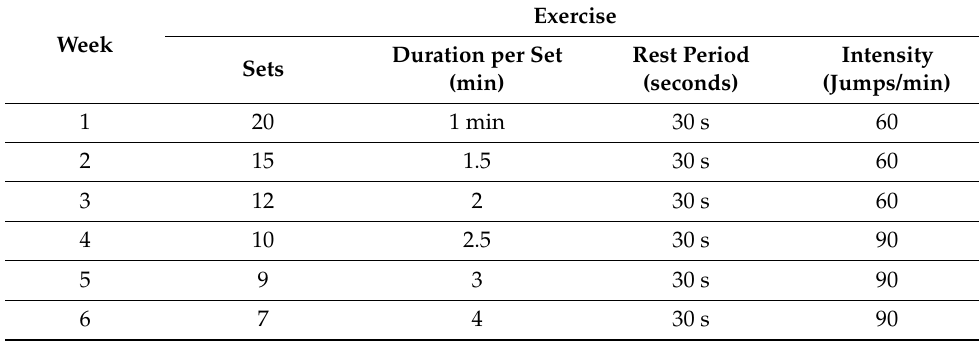
Table 1. Jump rope exercise protocol for the JW and JD